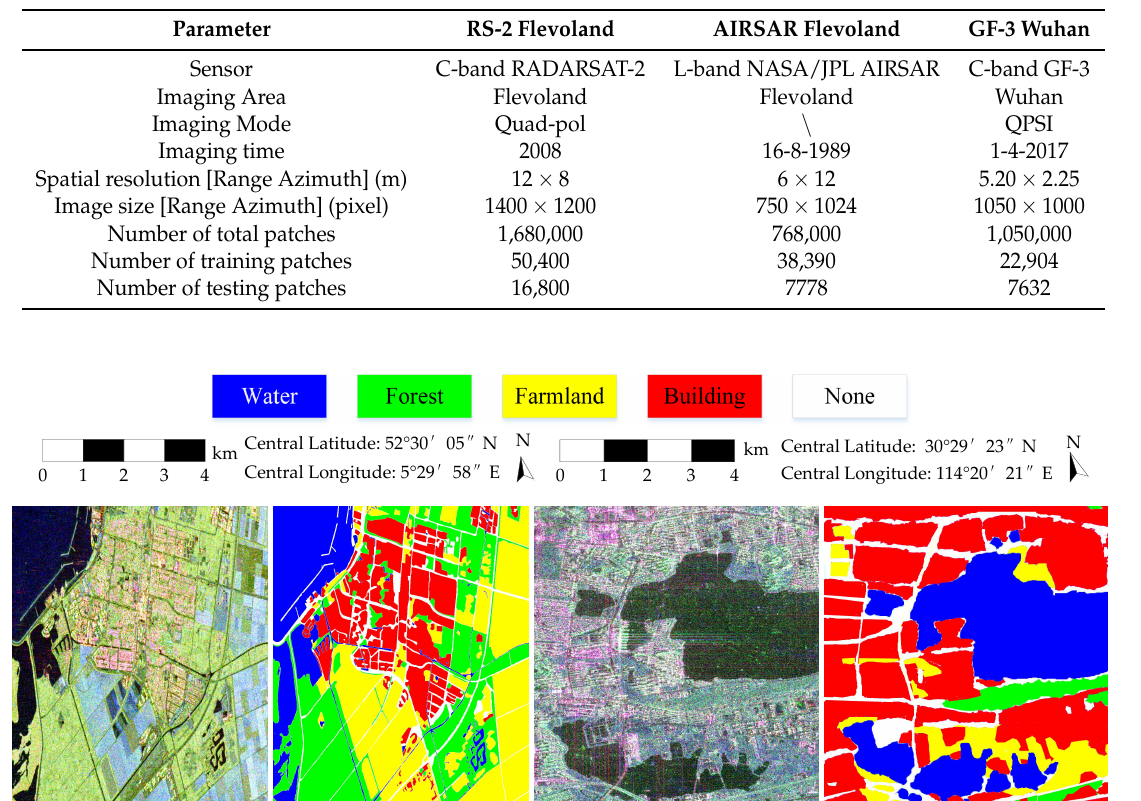
Table 1. Three real PolSAR datasets used for evaluation.